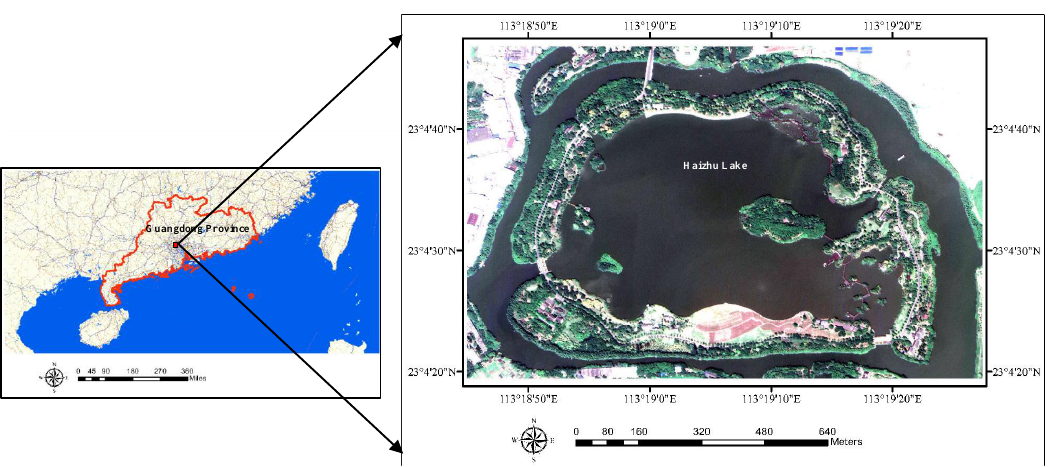
Figure 5. Geographic location of the study area.